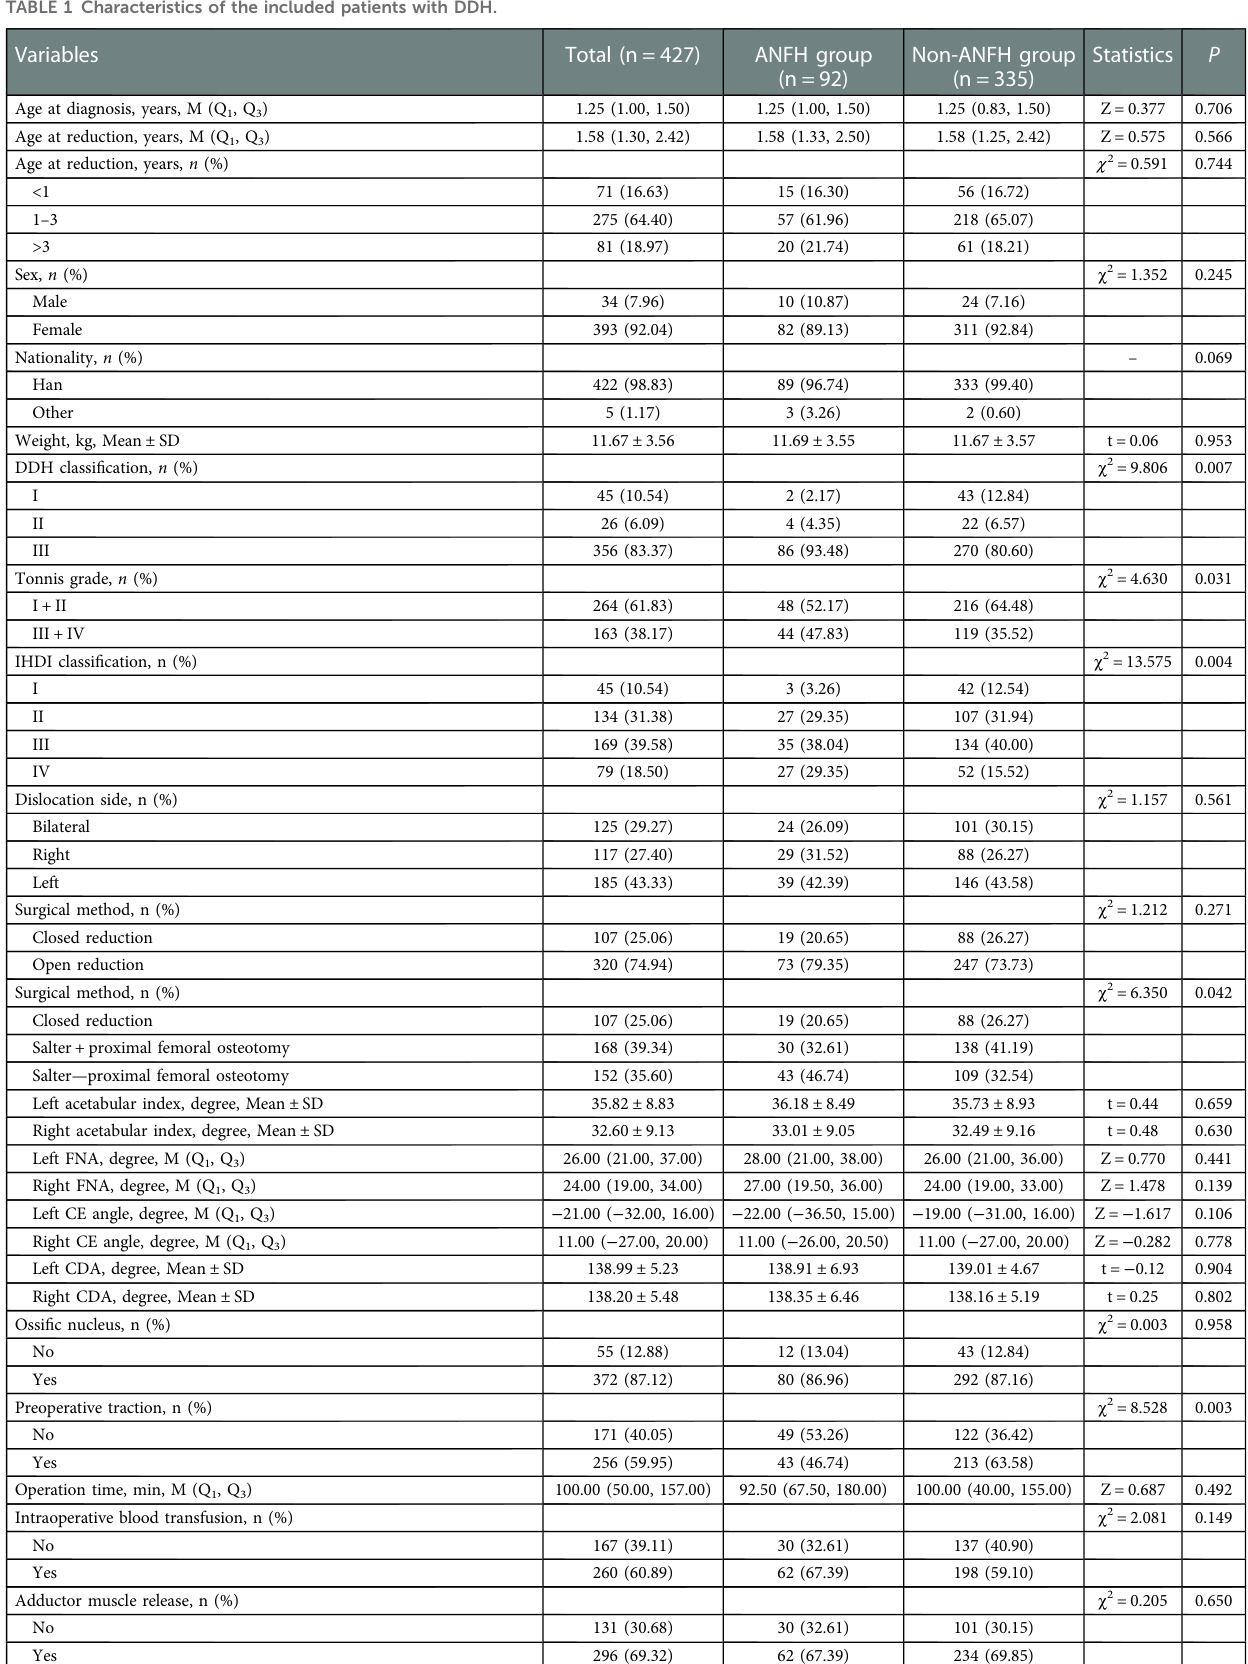
TABLE 1 Characteristics of the included patients with